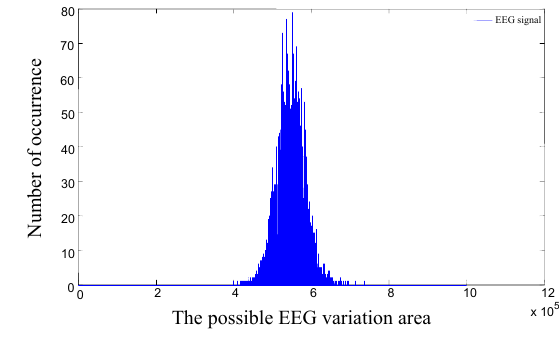
Fig. 6: Histograms of EEG sample captured by channel